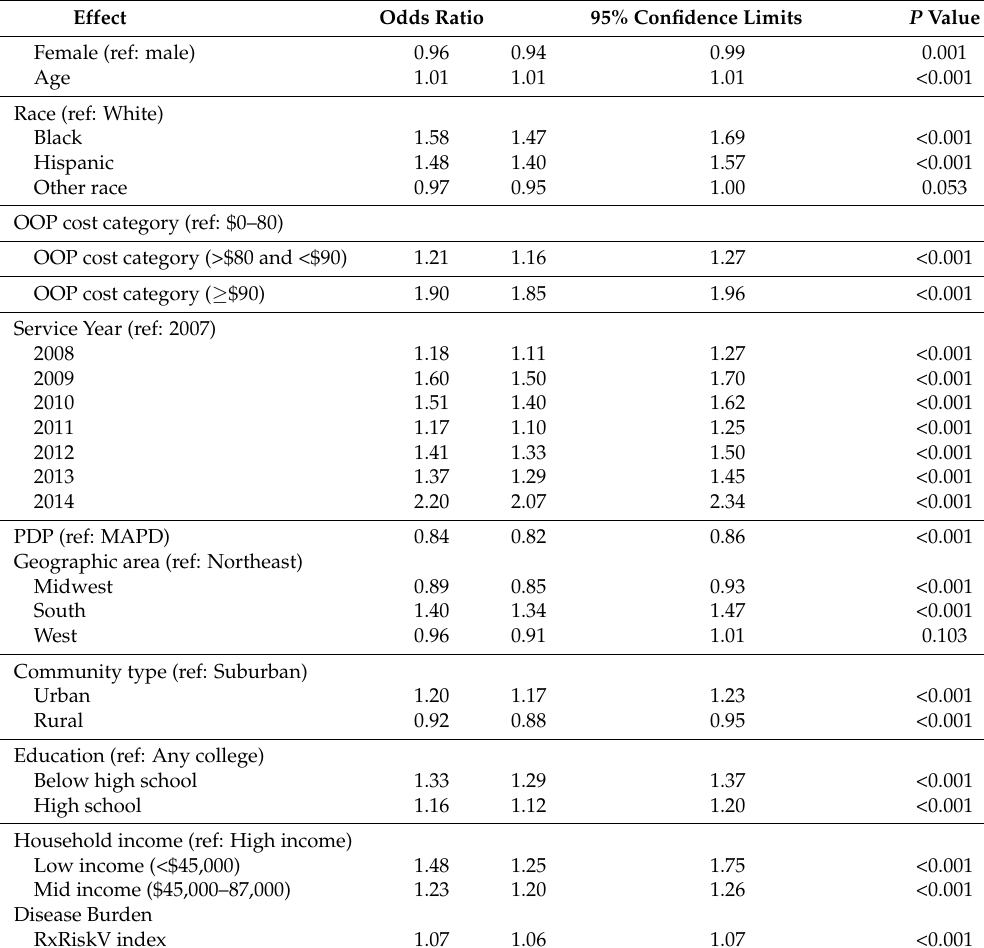
Table 3. Logistic Regression on Abandonment of HZ Vaccine among MAPD and prescription drug plans (PDP)